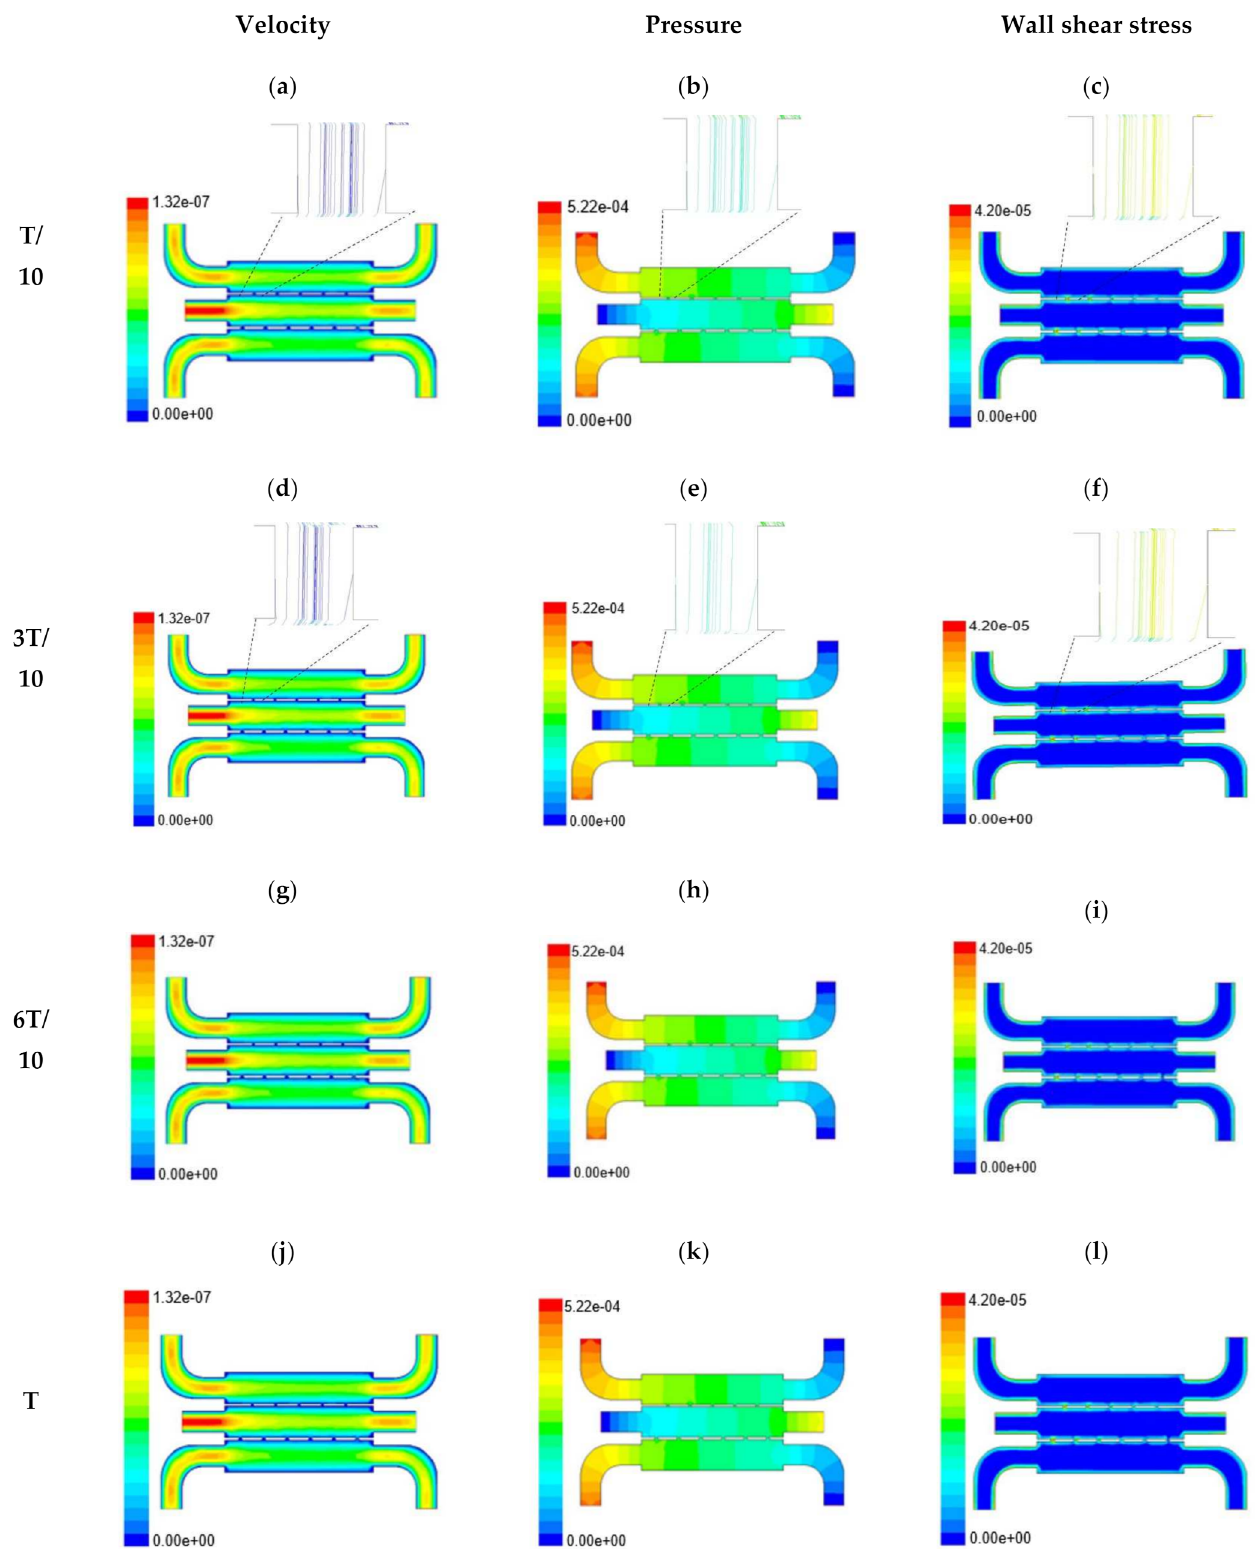
Figure 3. Numerical simulation of fluid flow inside the chip design 1 at flow rate of 5 µ L/min. The different time step was taken to understand the profile of velocity ( a , d , g , j ), pressure ( b , e , h , k ) and wall shear stress ( c , f , i , l ) along the